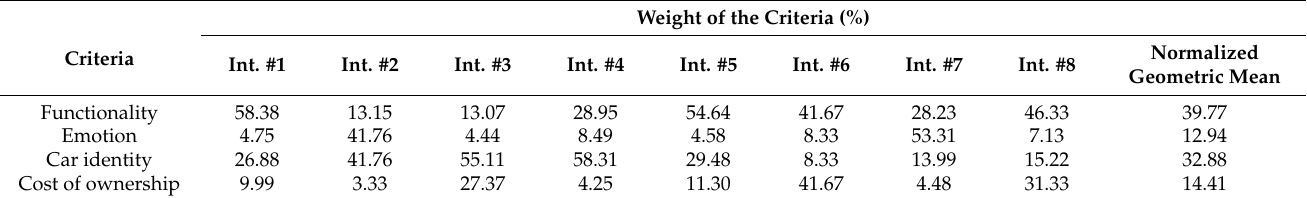
Table 18. Interviewees’ criteria weights prior to EV evaluation.